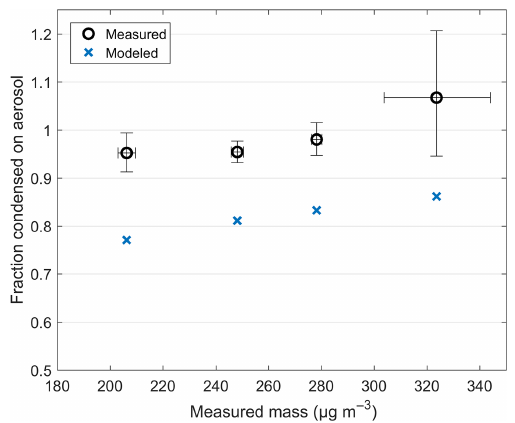
Figure 8. The fraction of the sulfuric acid mass condensed on aerosol phase as a function of measured sulfuric acid